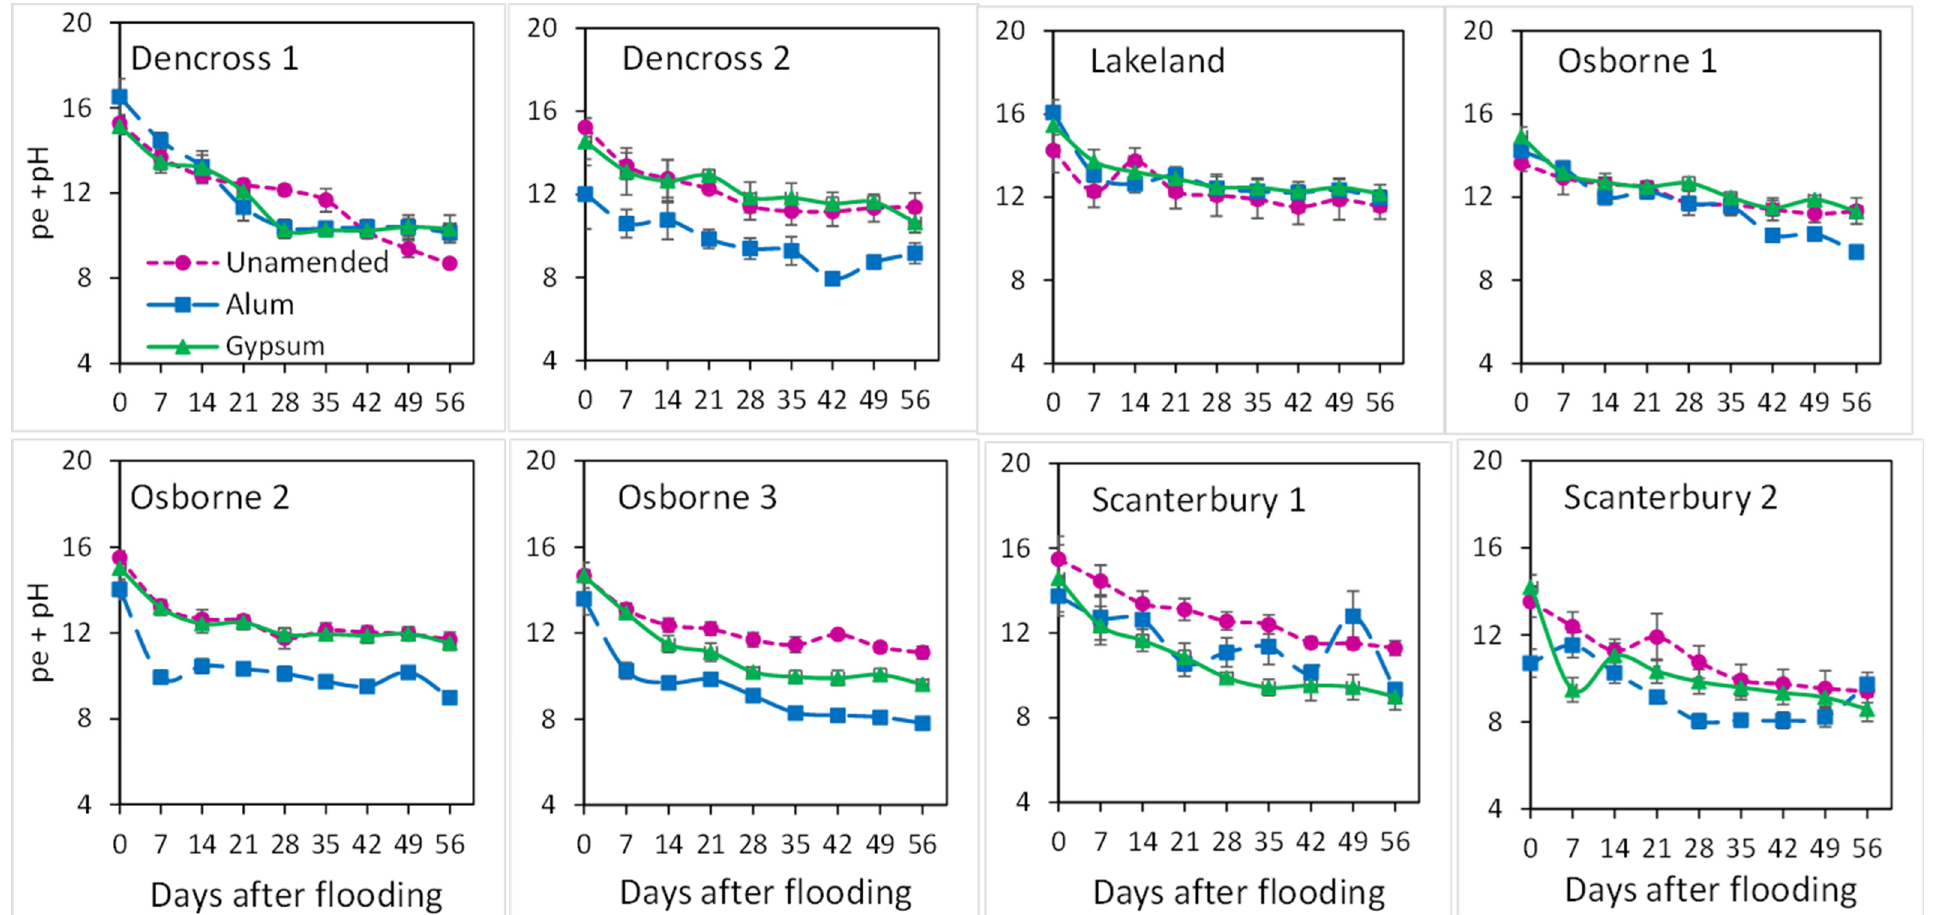
Figure 3. Change in pe + pH in unamended, alum-amended and gypsum-amended soil monoliths with time of flooding. The vertical bars indicate the standard deviation of the means (n = 3).